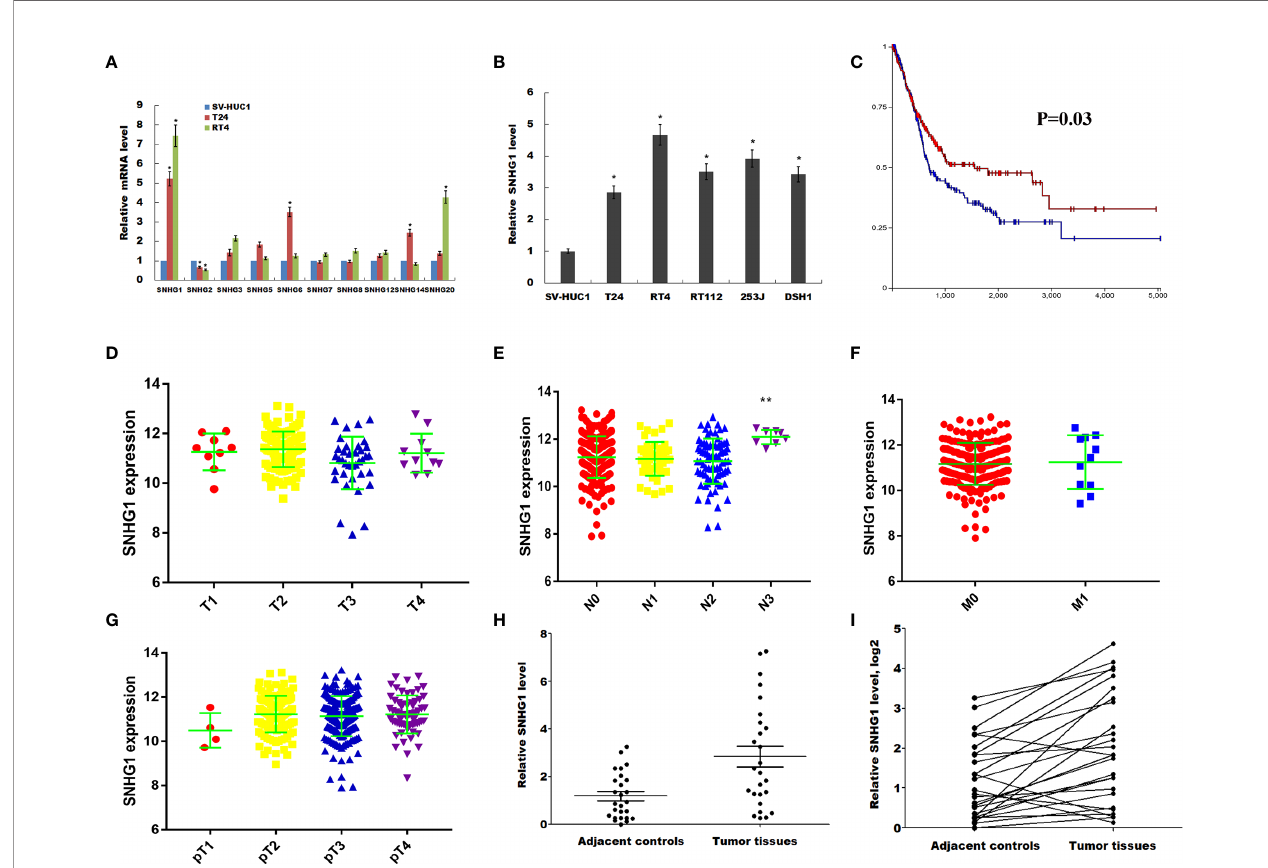
FIGURE 1 | Long noncoding RNA SNHG1 expression levels in bladder cancer cells and tissues. (A) Expression levels of SNHG1, SNHG2, SNHG3, SNHG5, SNHG6, SNHG7, SNHG8, SNHG12, SNHG14 , and SNHG20 in bladder cancer cell T24, RT4 and normal bladder epithelium SV-HUC1 cell; (B) Expression levels of SNHG1 in T24, RT4, RT112, 253J, DSH1 bladder cancer cell and normal epithelium of bladder SV-HUC1. (C) Bladder cancer patients were divided into SNHG1 - high or SNHG1 -low groups according to the median value of SNHG1 expression. Kaplan – Meier analysis of SNHG1 expression and OS in bladder cancer (data from TCGA database). (D) SNHG1 expression level in T-stage bladder cancer (data from TCGA database). (E) SNHG1 expression level in N-stage bladder cancer (data from TCGA database). (F) SNHG1 expression level in M-stage bladder cancer (data from TCGA database). (G) SNHG1 expression level in pathological T-stage bladder cancer (data from TCGA database). (H, I) SNHG1 expression levels in tumor and normal tissues of 26 bladder cancer patients (Data presented as mean ± SD, *p < 0.05, **p < 0.01 compared to the